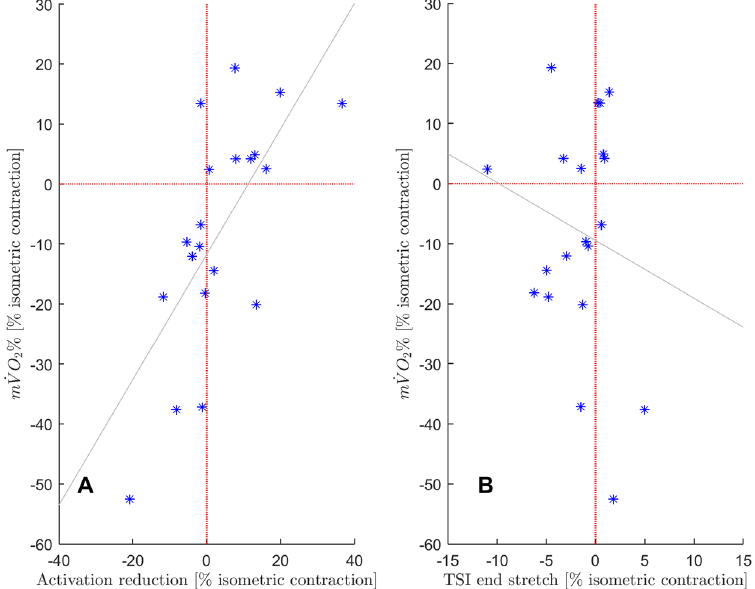
Figure 5. ( A ) Scatter plot between activation reduction (x-axis) and oxygen consumption (m  V O 2 ) (y-axis). Positive values on the y- and x-axis are attributed to activation reduction (AR) and reduced m  V O 2 compared to pure isometric contraction. Data shows a significant correlation between m  V O 2 % and activation reduction. (r = 0.69, p = 0.001). ( B ) Scatter plot between TSI value at the end of stretch (x-axis) and oxygen